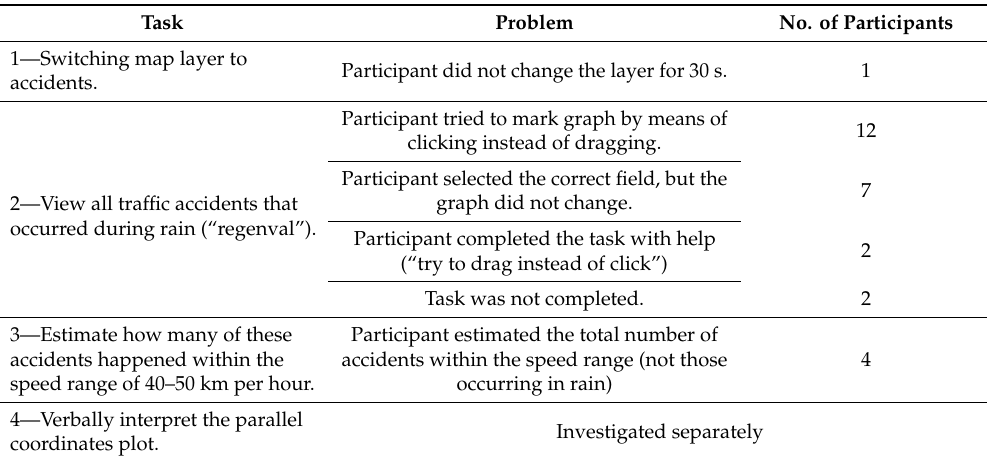
Table 4. Problems identified with the Flanders map.